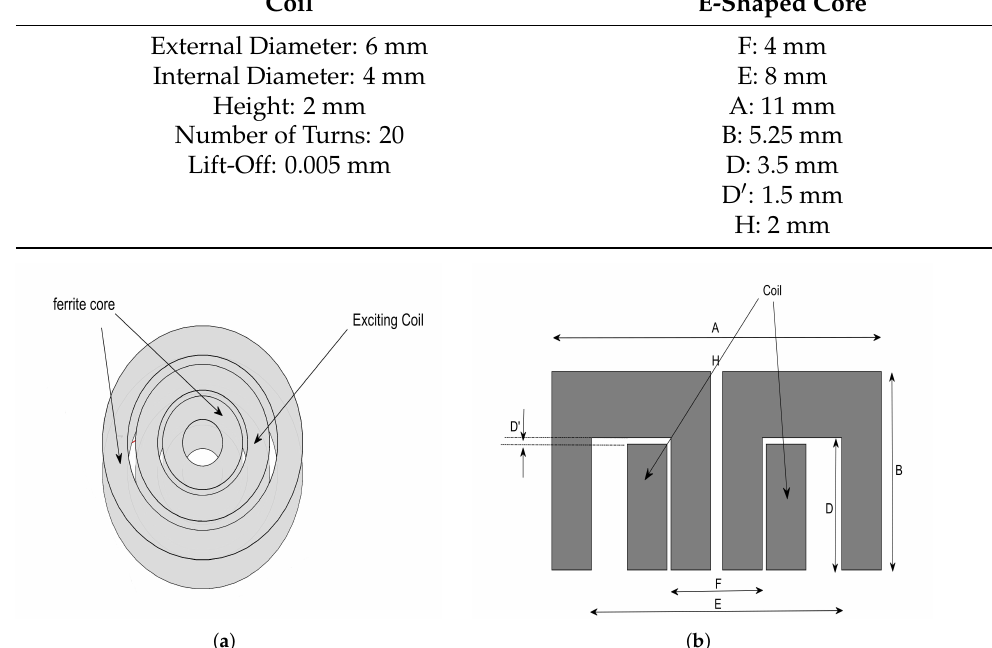
Table 1. Geometric characteristics of both the coil and the E-shaped core.